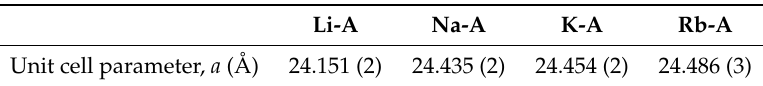
Table 1. Unit cell parameters for the exchanged